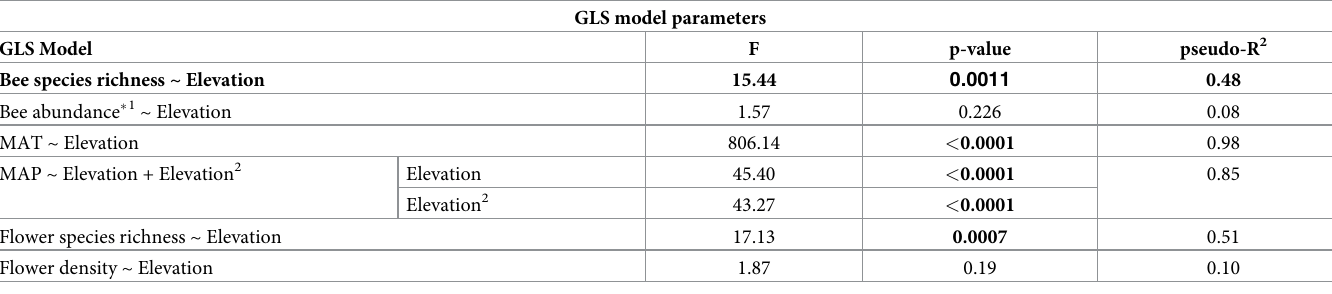
Table 1. Best GLS models for different response variables vs